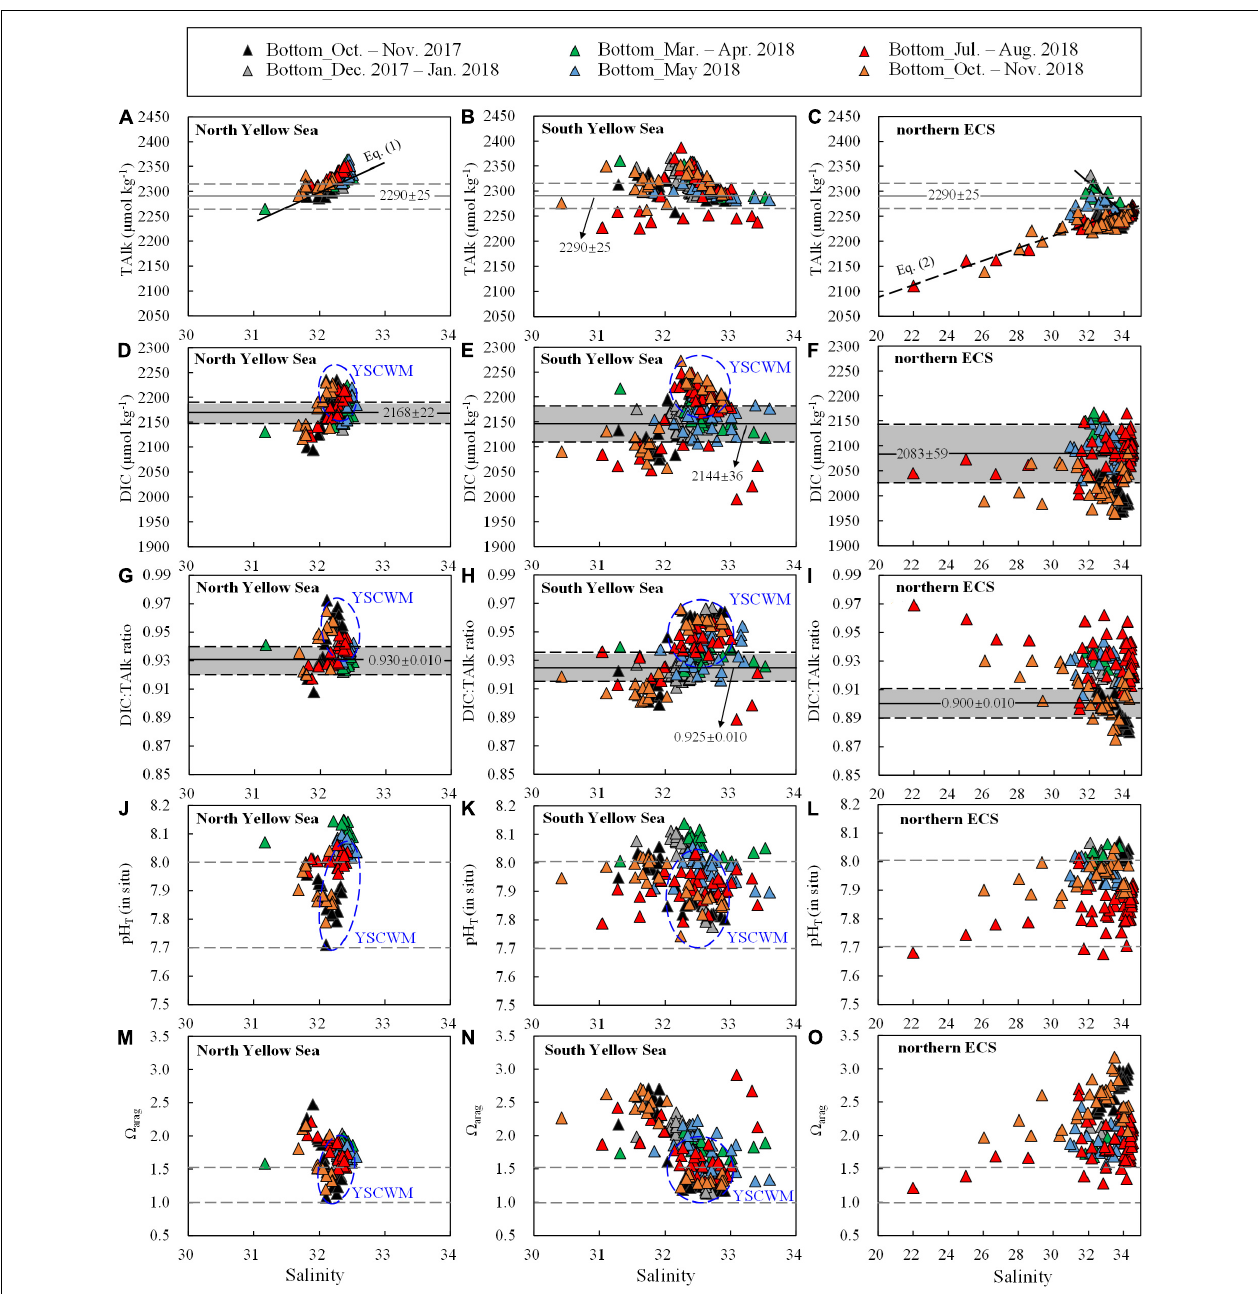
FIGURE 4 | Bottom-water (A–C) TAlk, (D–F) DIC, (G–I) DIC:TAlk ratio, (J–L) pH T ( in situ ) and (m–o) (cid:127) arag versus salinity. Data for the YSCWM are enclosed within blue ellipses. In (A–C) , 2290 ± 25 µ mol kg - 1 was the earlier usual value of TAlk in the Yellow Sea (Zhai et al., 2014b; Zhai, 2018). In (D–I) , gray shaded areas represent mean ± SD of wintertime/springtime DIC or DIC:TAlk ratios in individual regions. In (J–L) , the pH T of 8.0 is comparable with the present-day air-equilibrated pH T (corresponding to a mean air-equilibrated f CO 2 value of 415 ± 5 µ atm during our seasonal cruises in 2017–2018), while the pH T of 7.7 shows the doubled concentration of total hydrogen ions. In (M–O) , the (cid:127) arag of 1.5 shows a critical value that the net community CaCO 3 dissolution occurs in the North Yellow Sea (Li, 2019; Li and Zhai, 2019), while the (cid:127) arag of 1.0 indicates the critical value for the ideal aragonite dissolution.